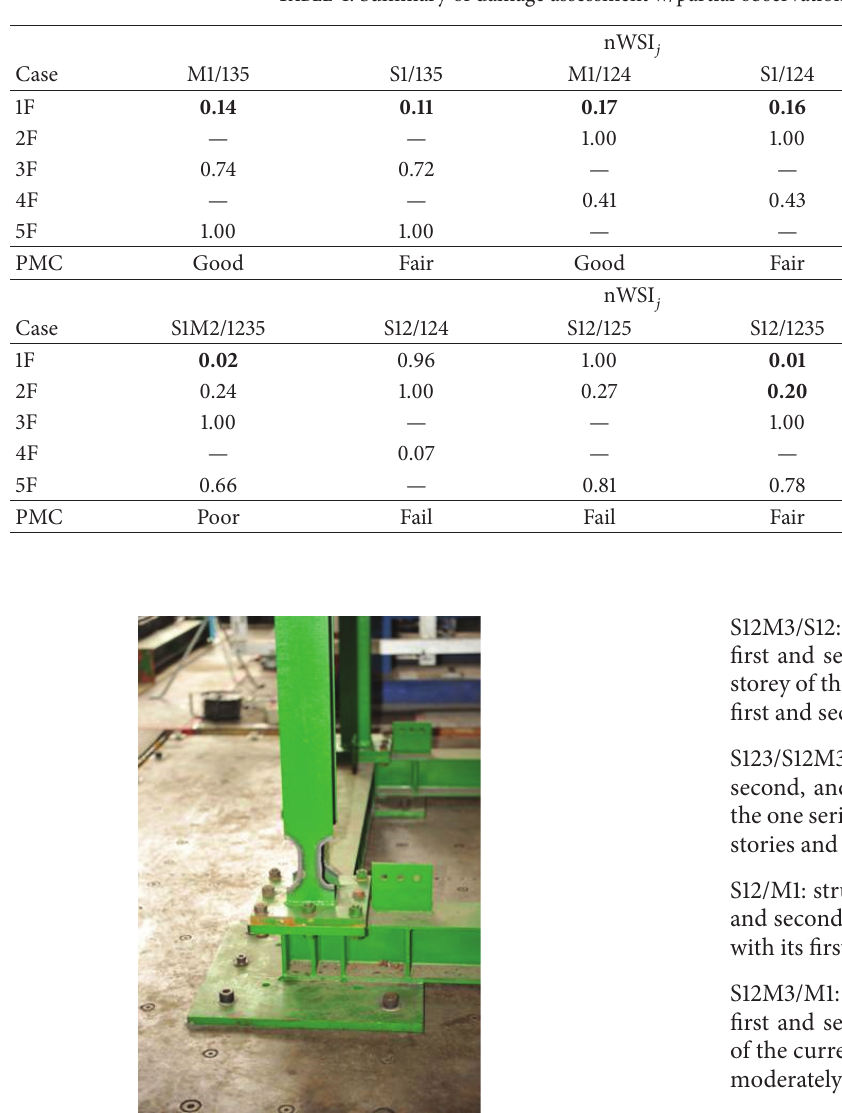
Table 4: Summary of damage assessment w/partial observation (experimental).